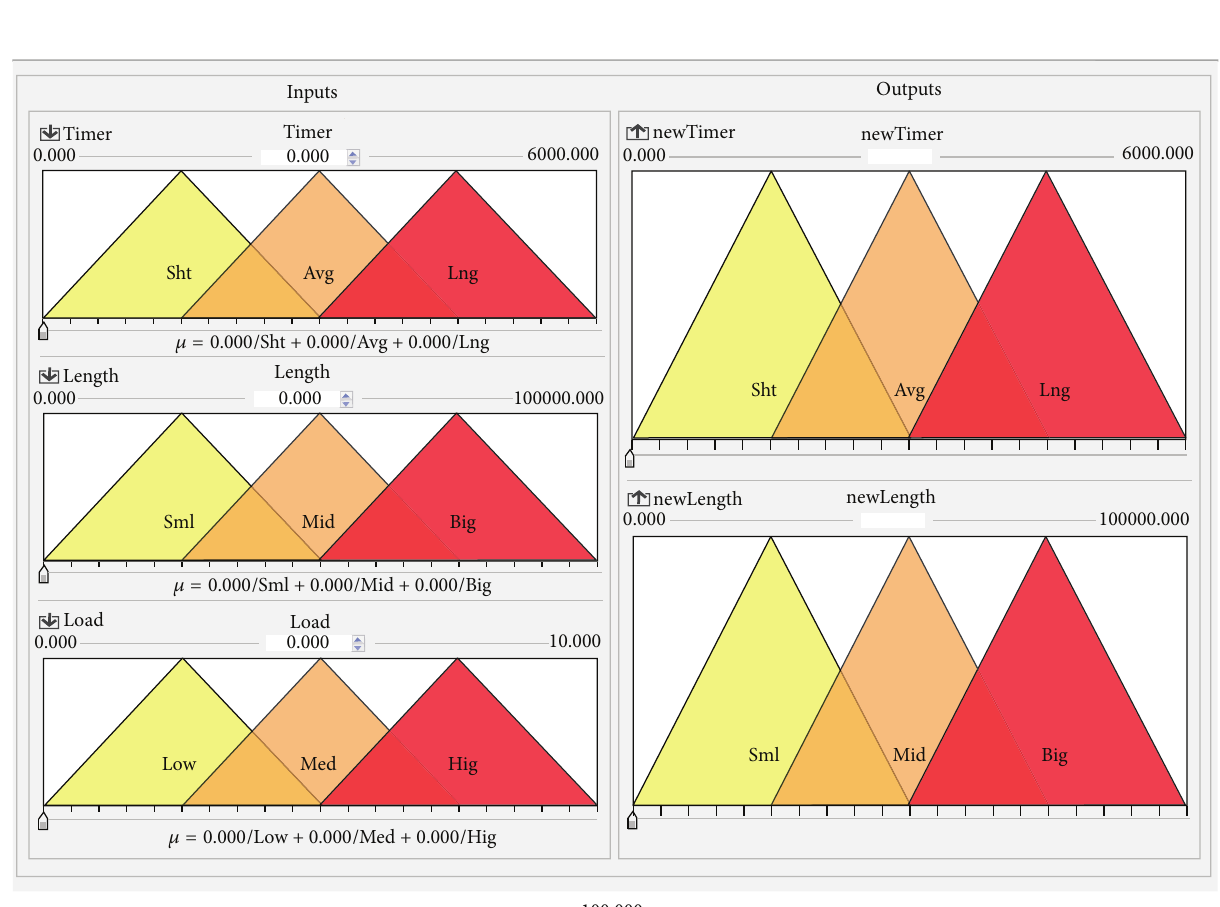
Figure 3: Input and output linguistic variables and their membership